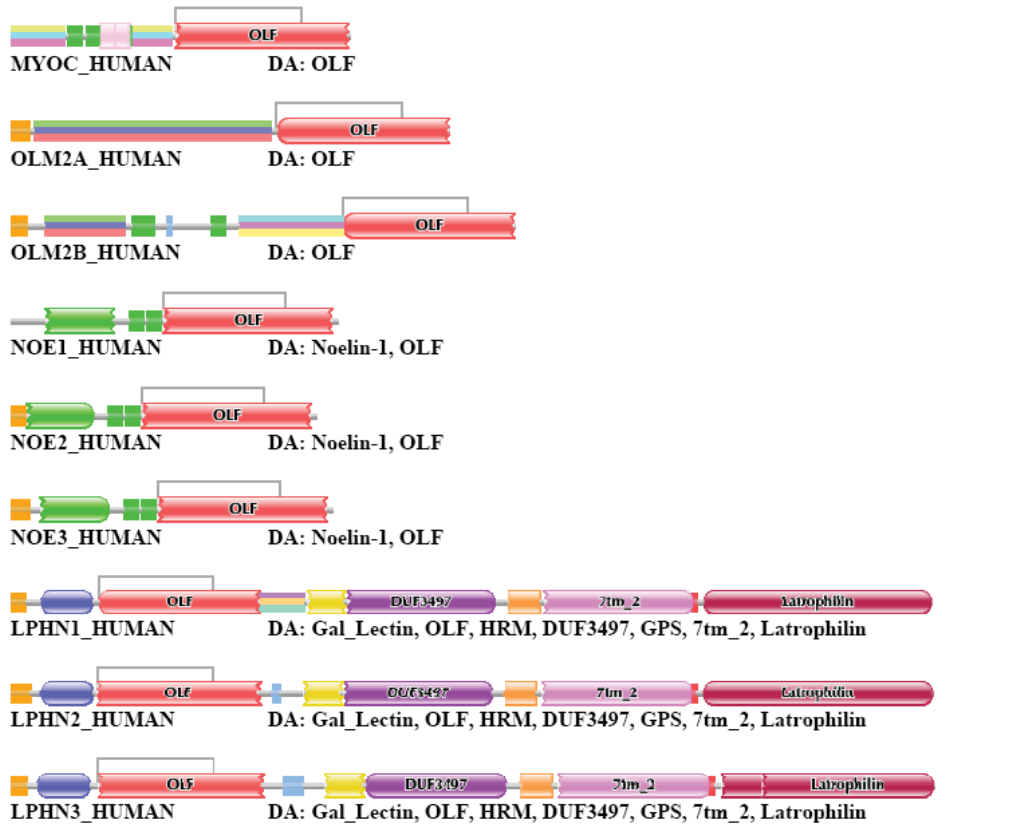
Figure S5. Comparison of the domain architecture of MYOC_HUMAN with those of its closests paralogs and some epaktologs.